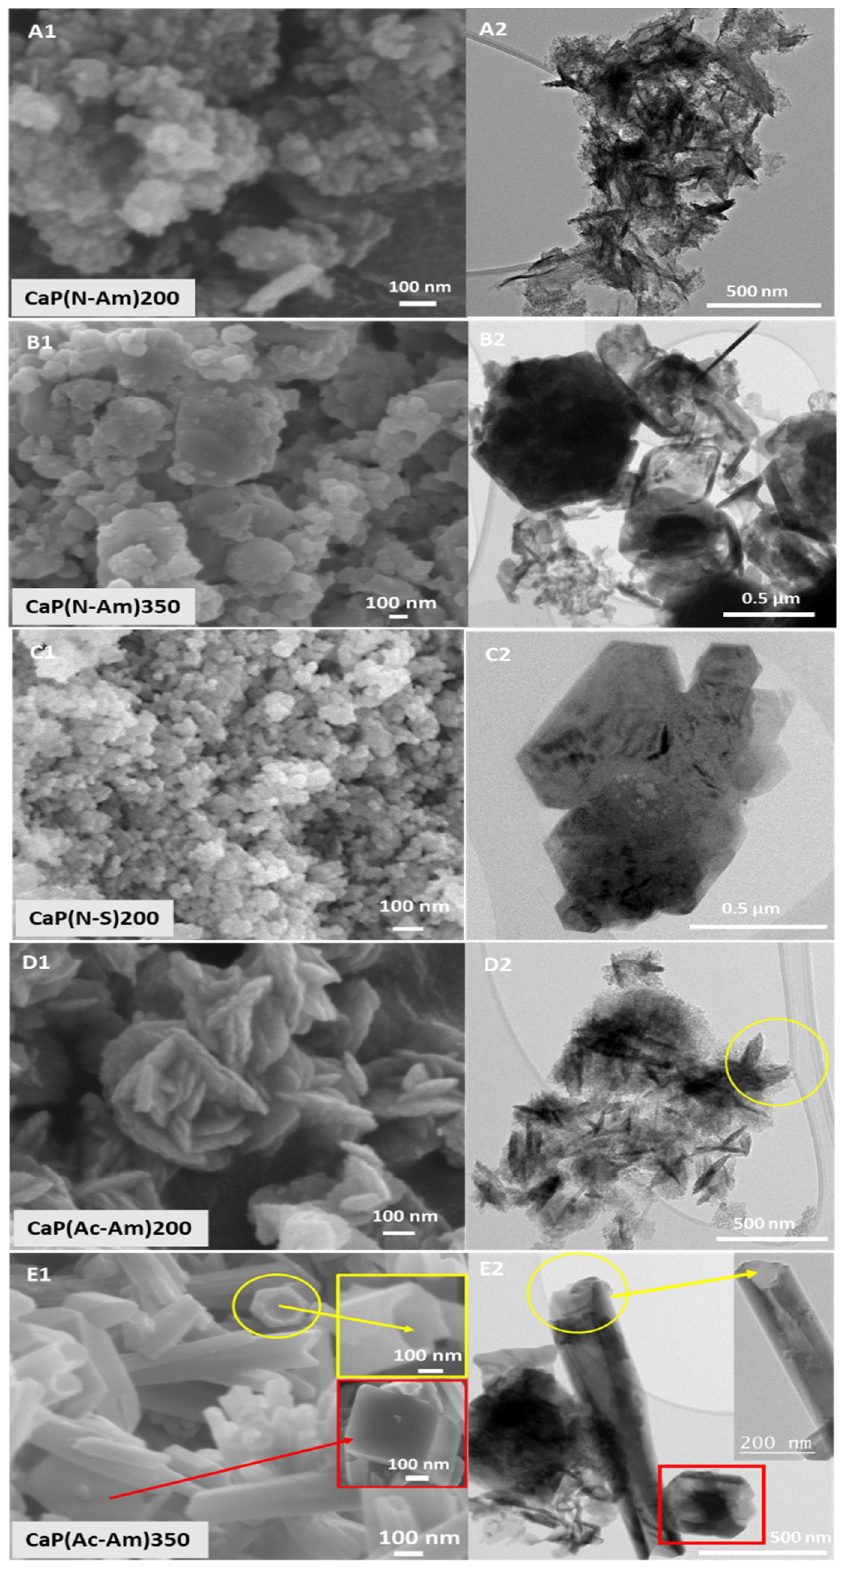
Figure 2. SEM and TEM images of samples synthesised using calcium nitrate tetrahydrate solution (pH = 11) and struvite solution (pH = 6) at 200 °C and 350 °C, where HNO 3 ( A – C ) and CH 3 COOH ( D , E ) were used to dissolve struvite and NH 4 OH ( A , B , D , E ) and NaOH ( C ) were used to adjust the pH of the precursor solutions. ( E ) The yellow colour highlights the tube morphology observed and the red colour highlights rhombohedral-shaped particles.